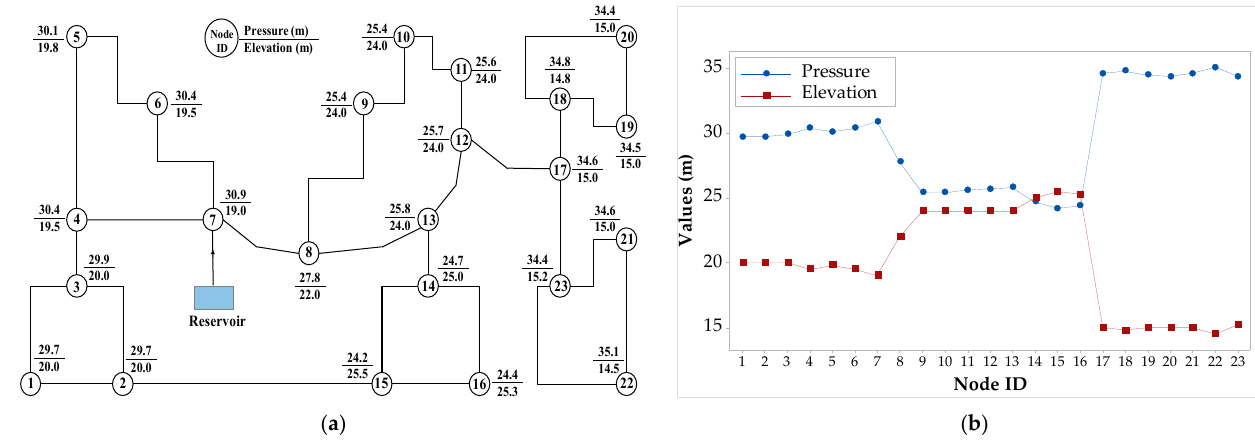
Figure 4. Sample network illustration: ( a ) WDN layout and ( b ) variation in pressure and elevation at nodes. The network is abstracted to the A matrix, TS matrix, and HS matrix obtained based on Equations (1), (3), and (4), respectively, and they are sequentially reported as three matrices as shown in Figure 5a–c. The TS matrix is described by Equation (3) and quantifies the topological similarity of a pair of nodes. According to Equation (4), the HS matrix illustrates the correlation between the elevations and head pressures of a pair of nodes. Before normalization for training the SOM, an integrated matrix created by adding up the three attribute matrices of A, TS, and HS was obtained based on Equation (7) as shown in Figure 5d.